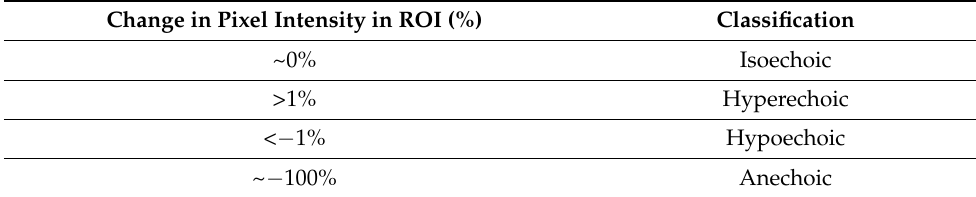
Figure 3. ( a ) Selection of ROI ‐ 1 and ROI ‐ 2 in the B ‐ mode image of the muscle without implants. ( b ) Selection of ROI ‐ 3 and ROI ‐ 4 in the B ‐ mode image with aerogel implants. Table 3. Table showing the echogenicity classification used in this study with US images of aerogels inserted SC and SM being compared to US images of the tissue.